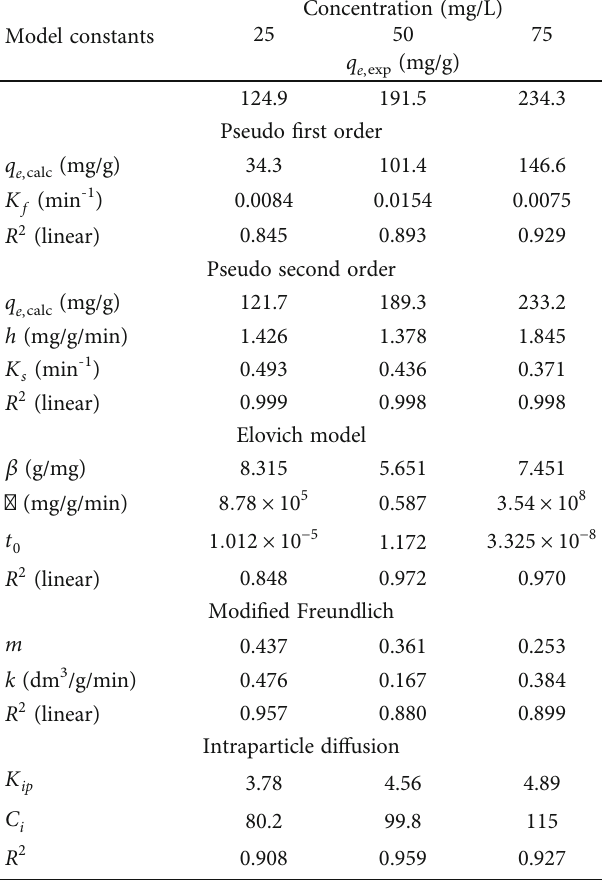
Table 4: Kinetic constants for CV sorption onto ACMAS. Model